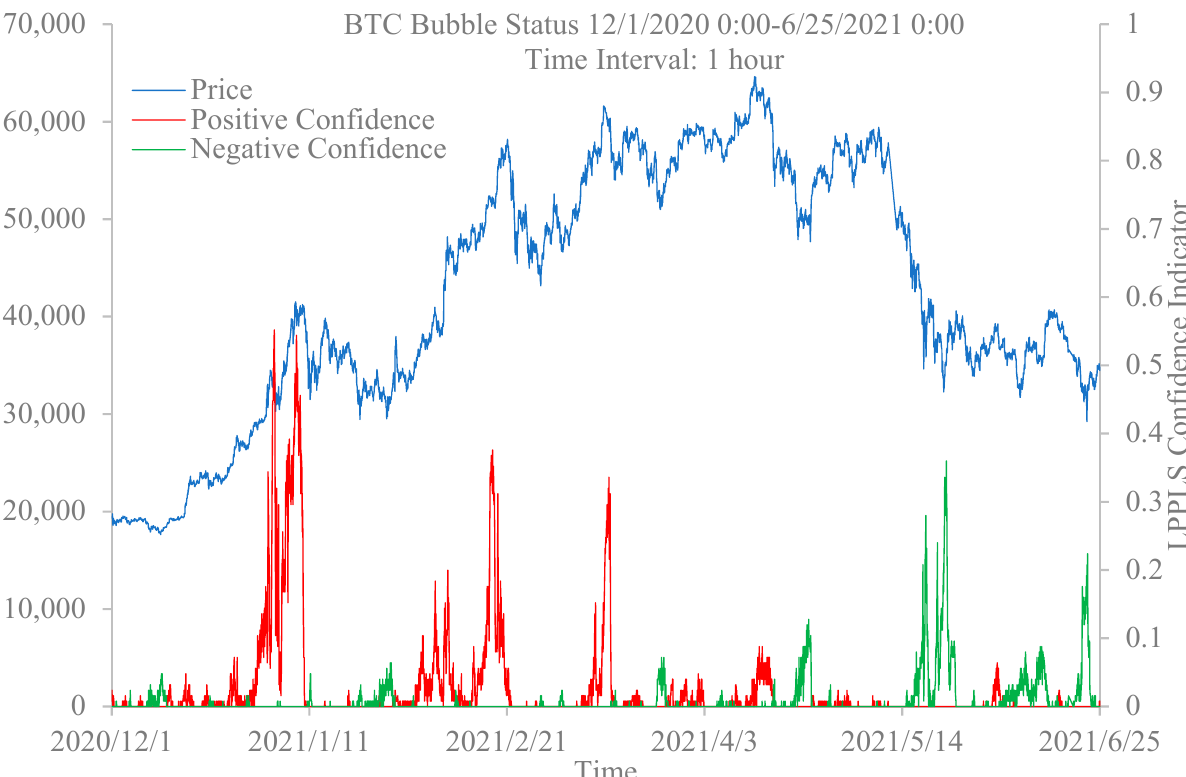
Figure 8. Hourly LPPLS confidence indicator for positive bubbles is shown in red and negative bubbles in green (right scale), along with the Bitcoin price in blue (left scale) from 12/1/2020 to 6/25/2021.